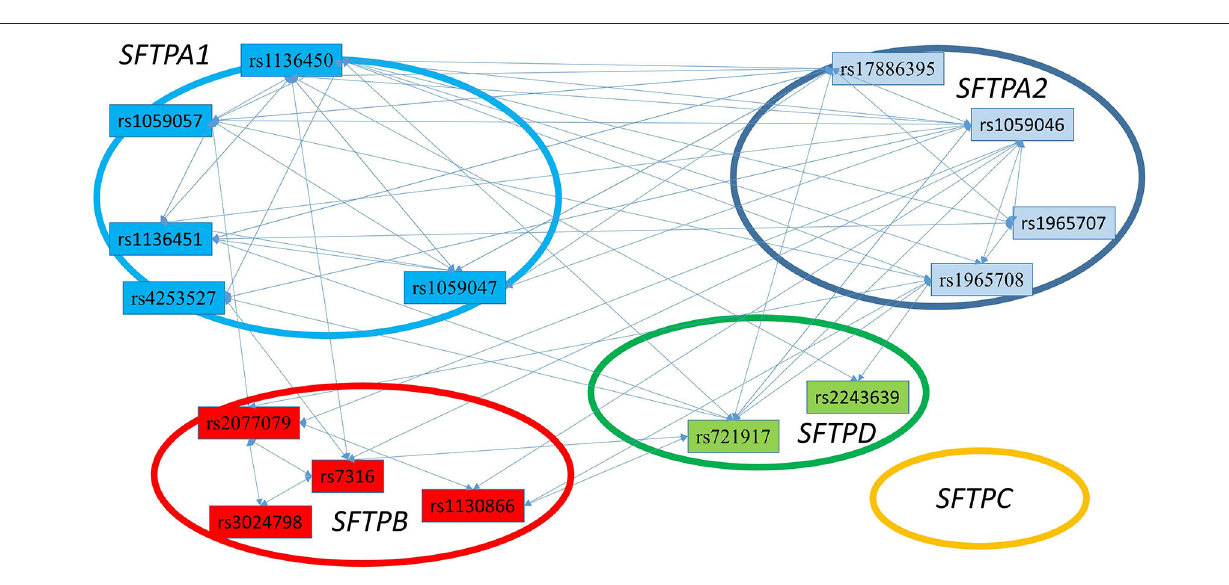
FIGURE 4 | The three SNP interactions associated with RDS susceptibility. The figure depicts intergenic and intragenic interactions of SFTPA1, SFTPA2, SFTPD, and SFTPB genes. No three SNP interactions were observed that involved SFTPC SNPs. There are a total of 28 three SNP interactions. All interactions (but one) involved SFTPA1 and/or SFTPA2